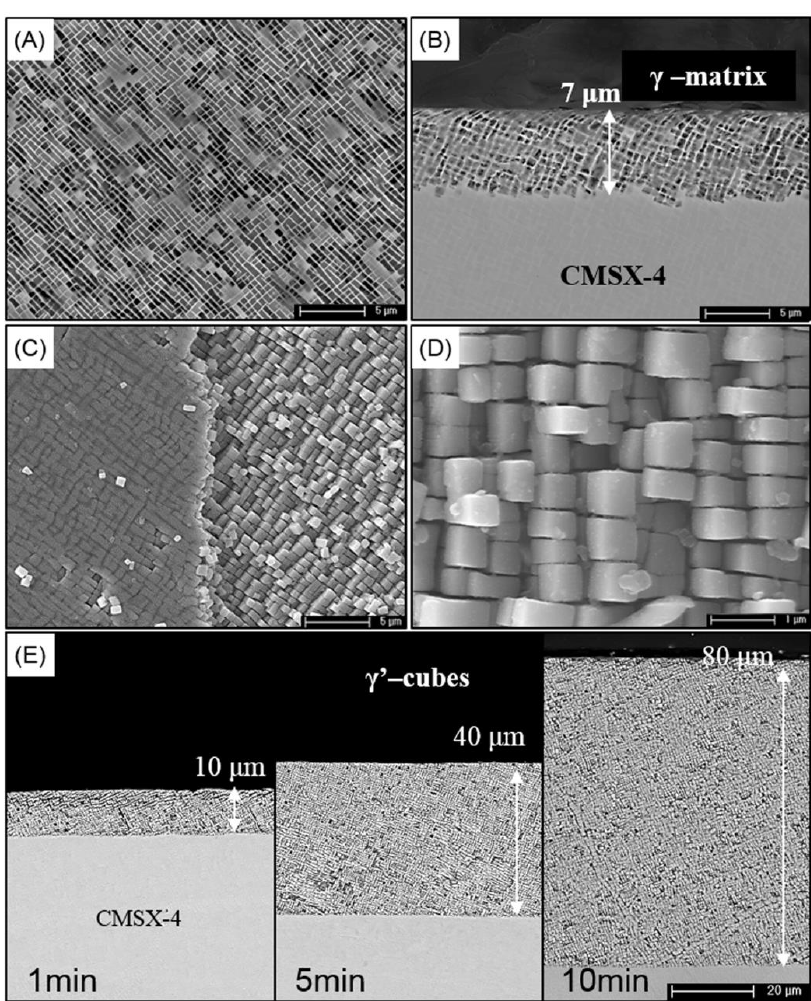
Figure 4. ( A ) Surface and ( B ) cross-sectional SEM images of γ’-etched substrate; ( C ) + ( D ) surface and ( E ) cross-sectional SEM images of γ-etched substrate with different etching times. The inner γ’-cubes were exposed by scratching the surface off.